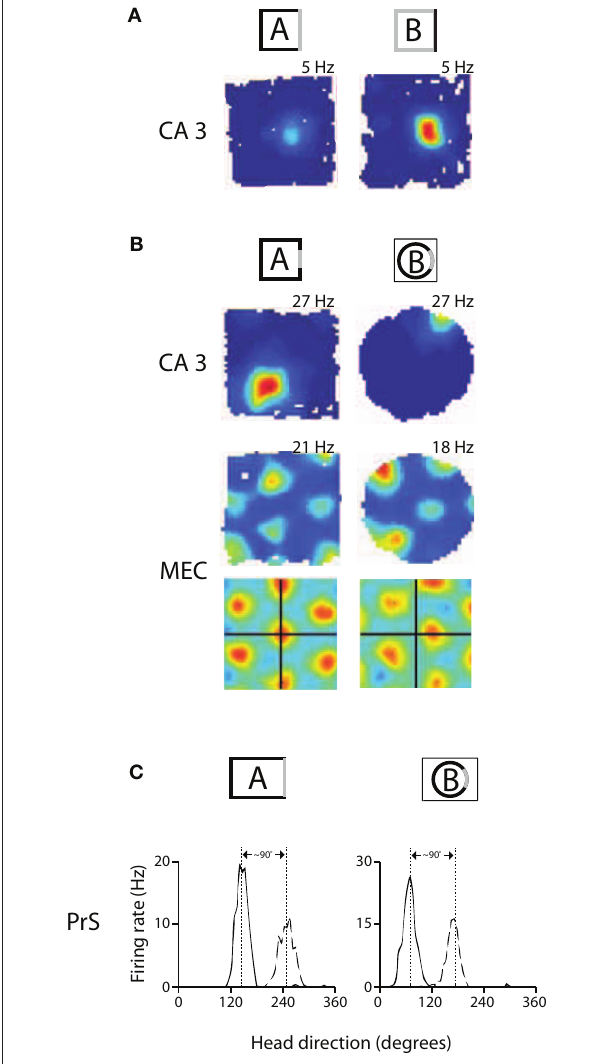
FIGURE 1 | Remapping experiments have shown that spatial maps in hippocampus and MEC are coordinated, while head direction preferences are coordinated across cells in presubiculum. (A) An example of rate remapping in area CA3 of the hippocampus. During rate remapping, place fields maintain a constant position but change firing rate; grid maps do not change during rate remapping. Left: Rate map of a CA3 place cell when the rat is in a box with three black walls and one white wall. Right: The same cell has a higher firing rate when the color scheme of the walls is reversed. (B) Switching recording enclosures elicits global remapping in the hippocampus, in which place cells change both their firing rate and position, and causes gird cells to undergo a shift in X-Y spatial phase that is apparent in the spatial cross-correlations beneath the rate maps [the cross-correlations are a comparison of rate maps at all overlapping spatial shifts for the grid cell in environment A vs. A’ (left) or in A vs. B (right)] (adapted from Fyhn et al., 2007). (C) Changing recording enclosures causes head direction cells in the dorsal presubiculum (PrS) to change their preferred directions, but the relative difference in the cells’ preferred directions is conserved across environments. Left: Head direction tuning for a pair of cells recorded from PrS in a rectangle. Right: the cells shift their directional tuning when the rat is placed in a cylinder, but the relationship between the cells’ preferred firing directions is nearly the same (adapted from Taube et al.,